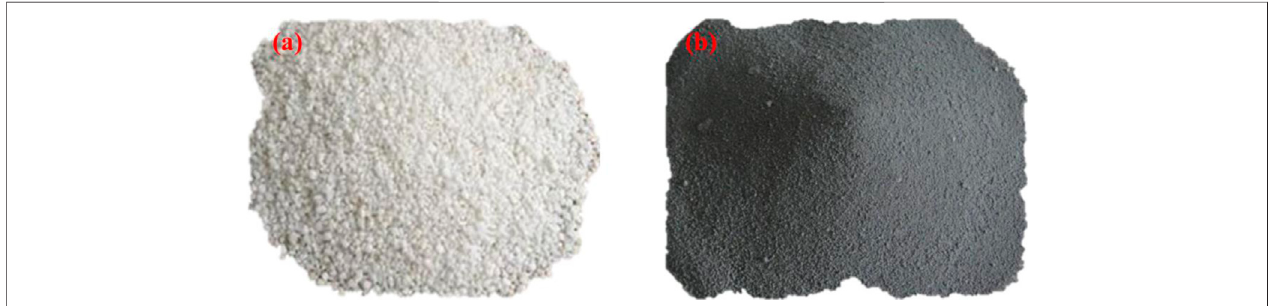
FIGURE1| Macro-morphologyof fl oatingbeads (A) andmacro-morphologyofmicro-silica (B) 105(3)Additives,mainly fl uidlossagentG33SanddispersantUSZ, were provided by Weihui 106 Chemical Co., Ltd.